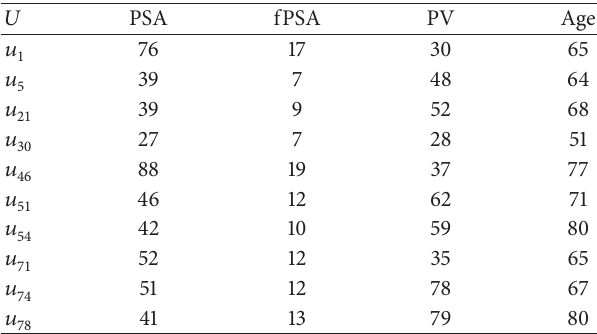
Table 2: The input PSA, fPSA, PV, and age values of several patients.